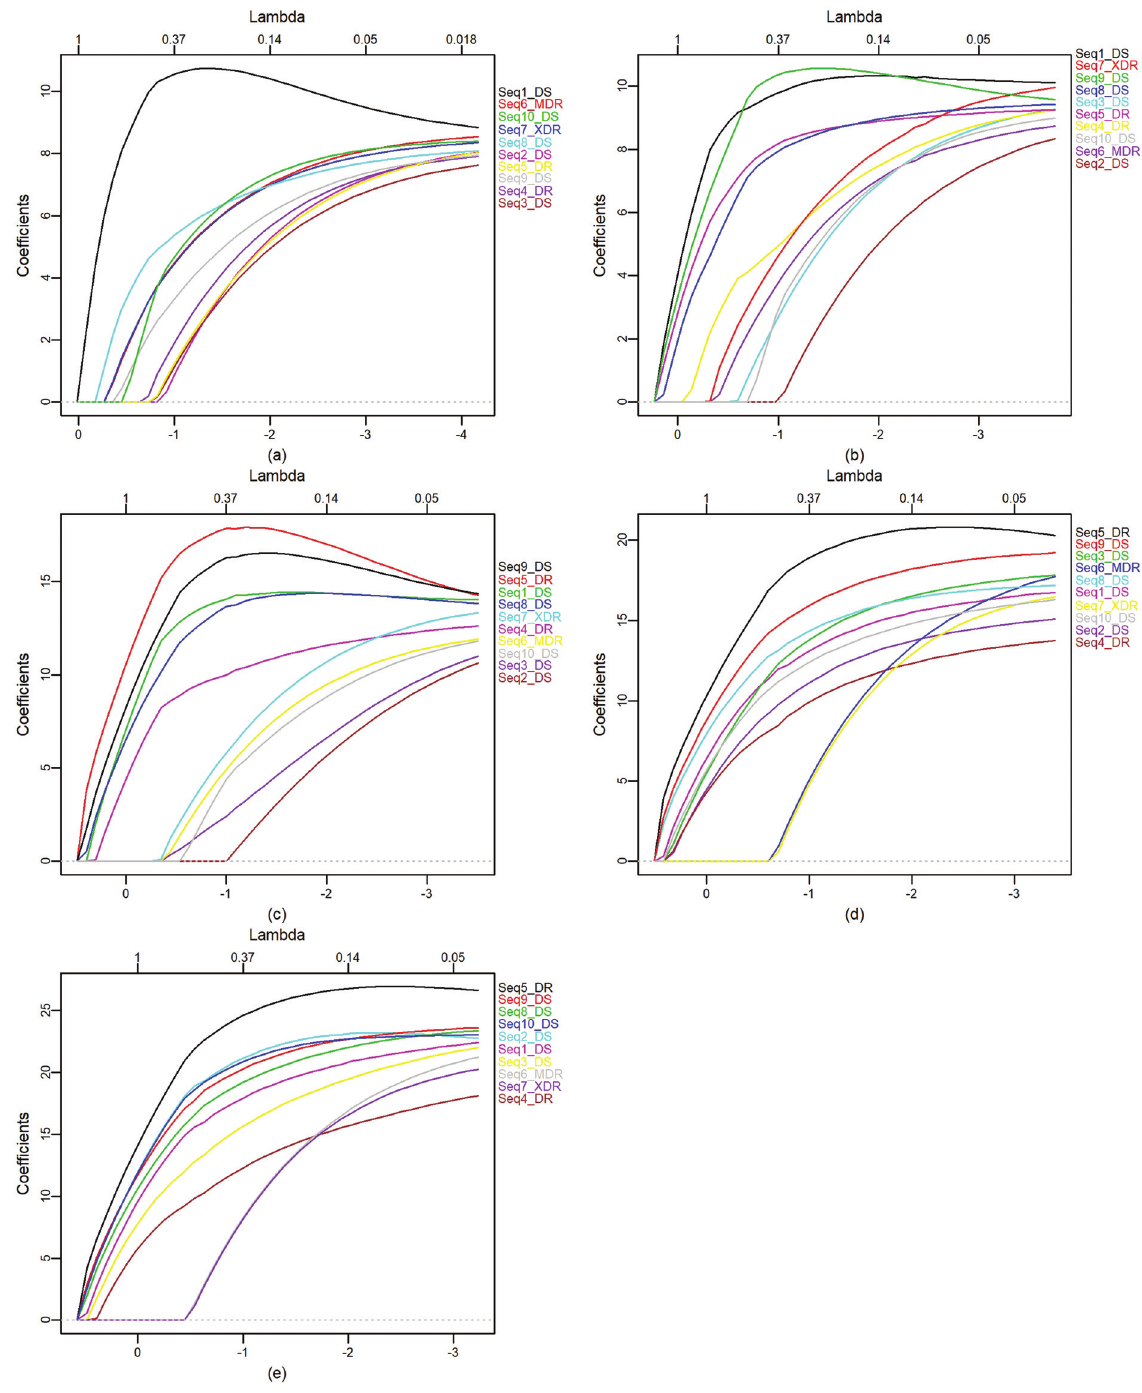
Figure 4 - Elastic net for: (a) d1, (b) d2, (c) d3, (d) d4, and (e) d5